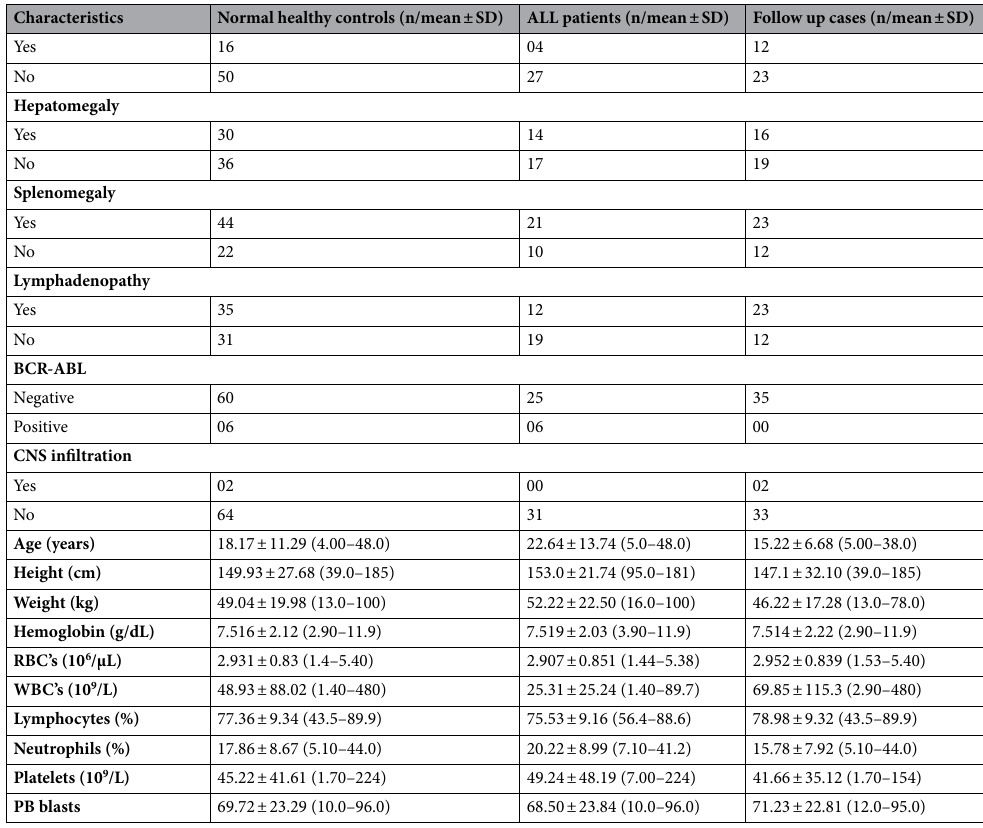
Table 1. Baseline characteristics of participants, demographic and clinical history of the patients enrolled in the study. The values are n = number and/or mean ± standard deviation (minimum–maximum). The data tabulated is analyzed by SPSS for windows (version 21).